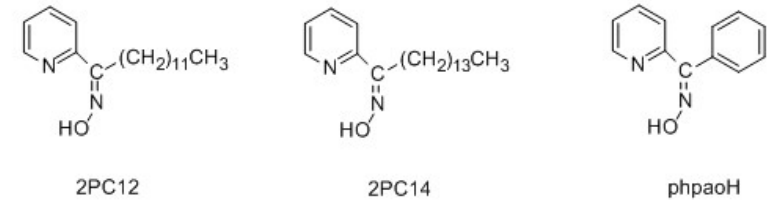
Figure 1. Structural formulae of the Cd(II) extractants, 2PC12, 2PC14, and the model ligand phenyl 2-pyridyl ketoxime (phpaoH) used in the present work.